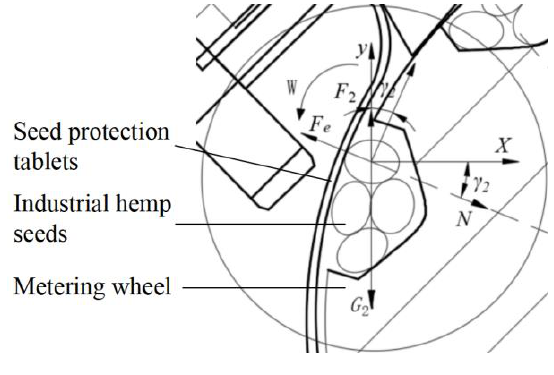
9 of 24 Figure 6. Seed cleaning process analysis. Comprehensive Formula (10):